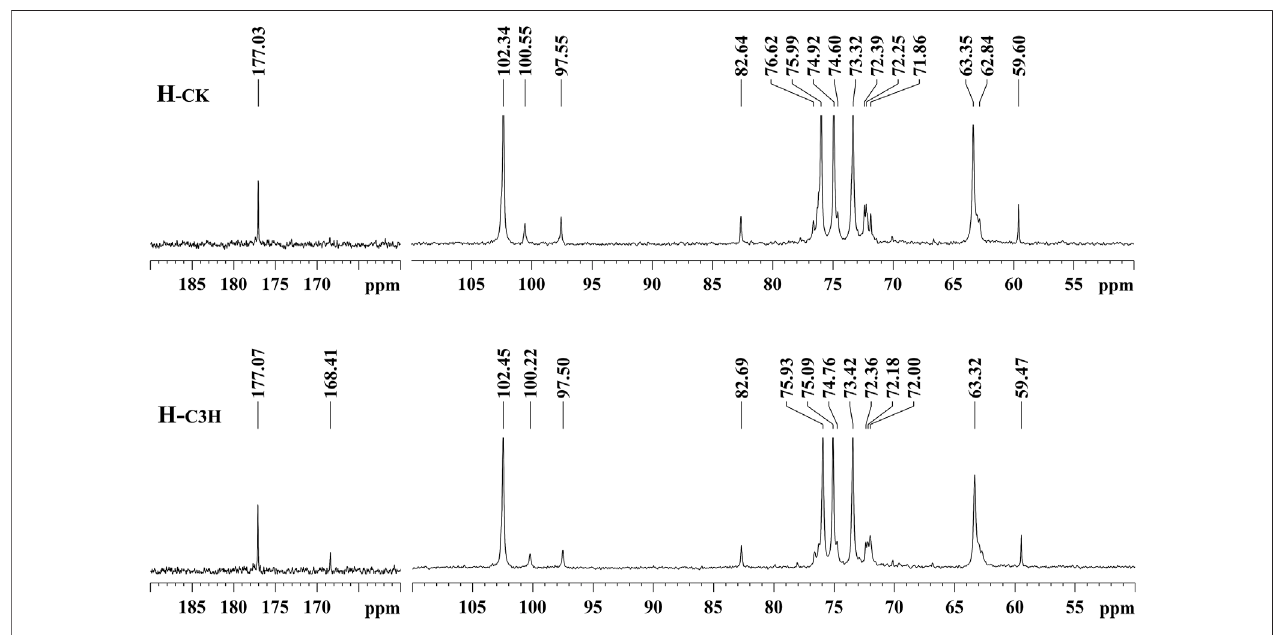
FIGURE 2 | 13 C NMR spectra of the